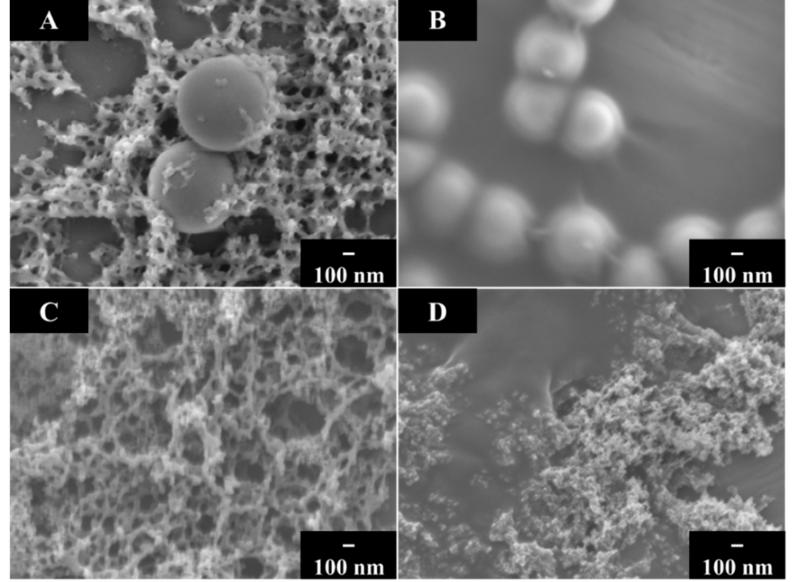
Figure 3. SEM images of ( A , B ) PMMA-micron size composites and ( C , D ) PMMA-nanosilica compos- ites, ( A , C ) as-deposited and room-temperature-dried, ( B , D ) annealed at 200 ◦